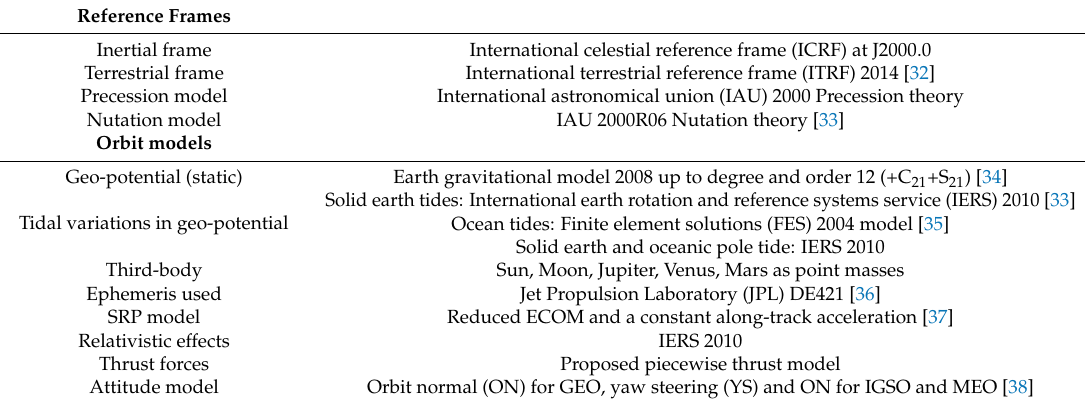
Table 1. Reference frames and dynamic orbit models in